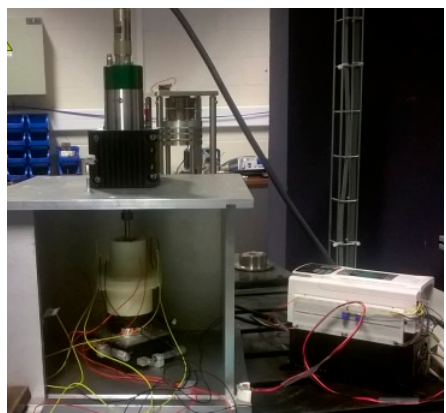
Figure 7. Picture of the test bench for operation of the prototype in quasistatic conditions, with an